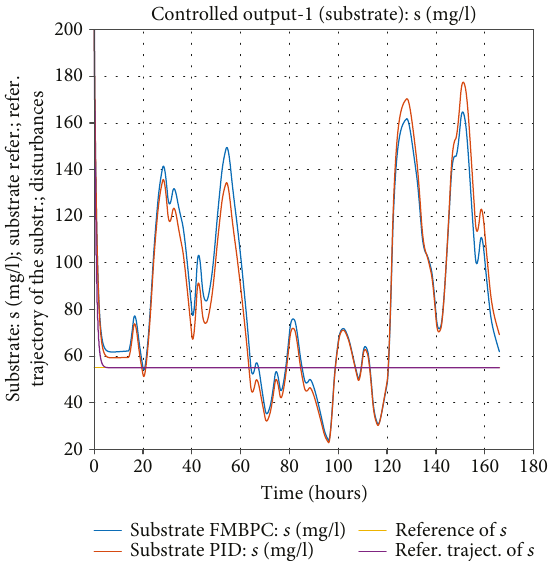
Figure 22: Reactor biomass by FMBPC and PID (case